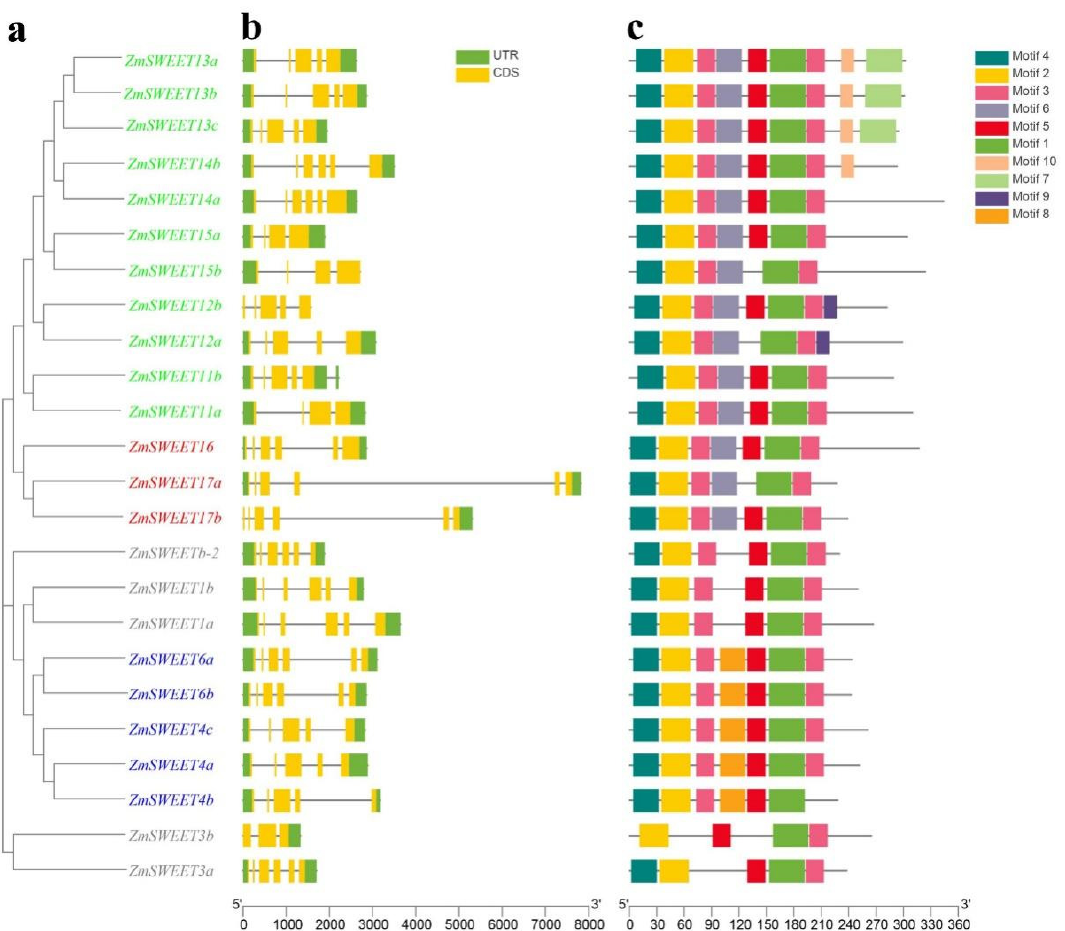
Figure 2. Conserved motifs and gene structure analyses of maize SWEETs based on phylogenetic relationships. All motifs were identified with the MEME Suite using the complete amino acid sequences. Exon–intron structure analyses were performed with TBtools. ( a ) Neighbor-joining tree indicating evolutionary relationships. Clades I, II, III, and IV are indicated in gray, green, blue, and red, respectively. ( b ) Exon–intron structure. Green boxes, yellow boxes, and black lines indicate the untranslated region, coding sequence, and gene length, respectively. ( c ) Conserved motifs.